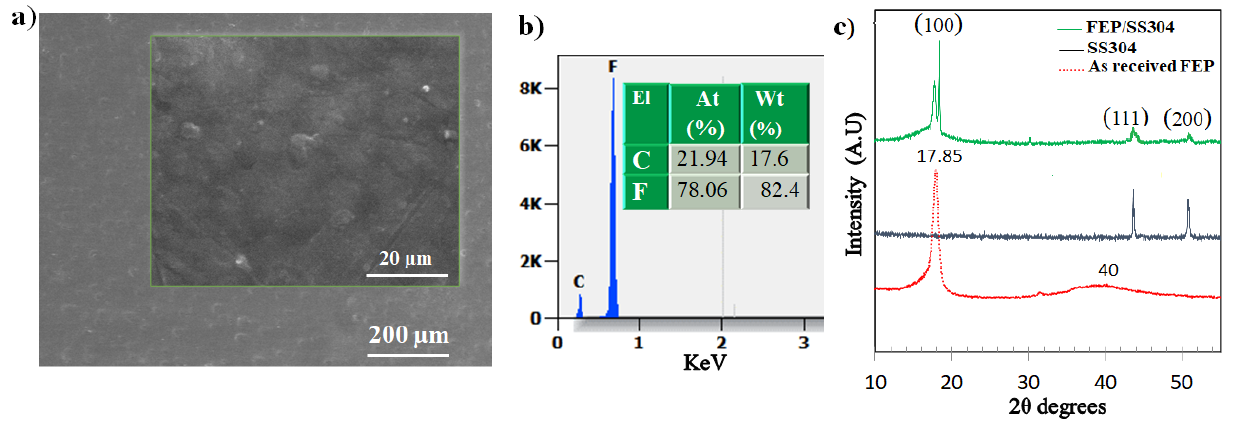
Figure 2. ( a ) SEM analysis of the FEP coatings, ( b ) a typical EDS spectrum, and ( c ) XRD pattern of the coatings.